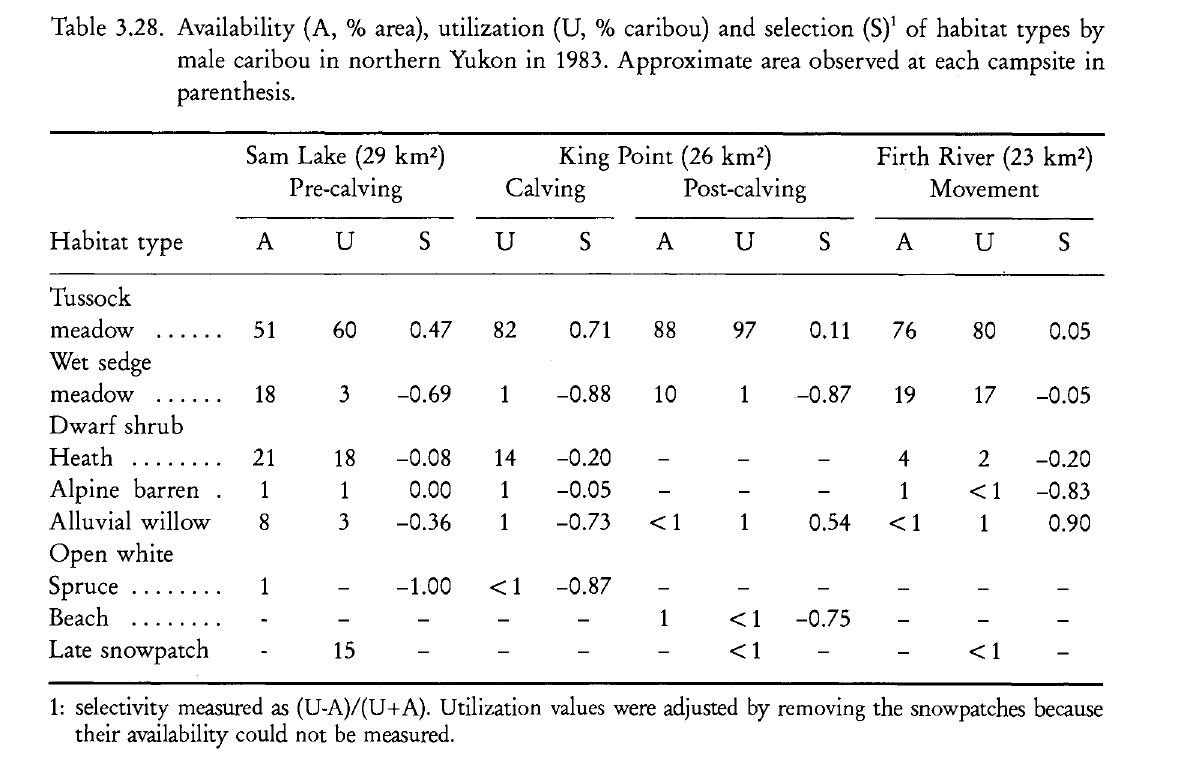
Table 3.28. Availability (A, % area), utilization (U, % caribou) and selection (S) 1 of habitat types by male caribou in northern Yukon in 1983. Approximate area observed at each campsite in